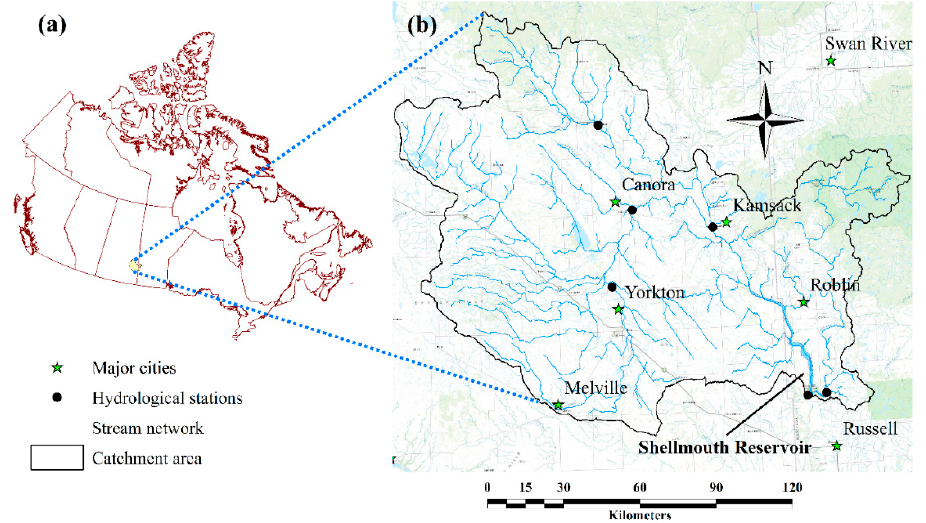
Figure 1. Geospatial location of the Upper Assiniboine River basin including the Shellmouth reservoir (Lake of the Prairie): ( a ) shows area of interest in Canada while ( b ) shows study area along with major cities and hydrometric stations utilized to construct the model.